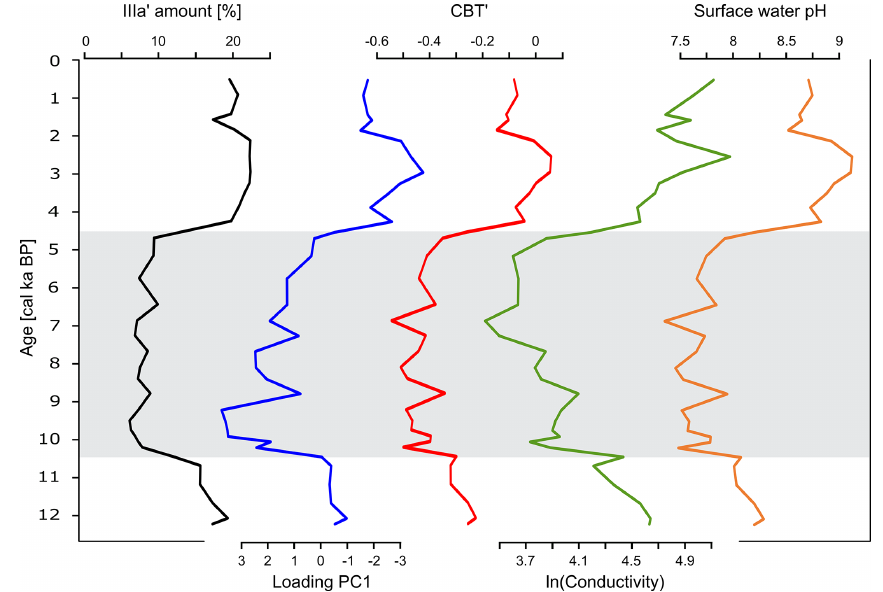
Figure 5. Downcore functions for IIIa (cid:48) amount, the PC1 loading, CBT (cid:48) , ln ( conductivity ) (Eq. 12 in Raberg et al., 2021), and surface water pH of the Garba Guracha brGDGT